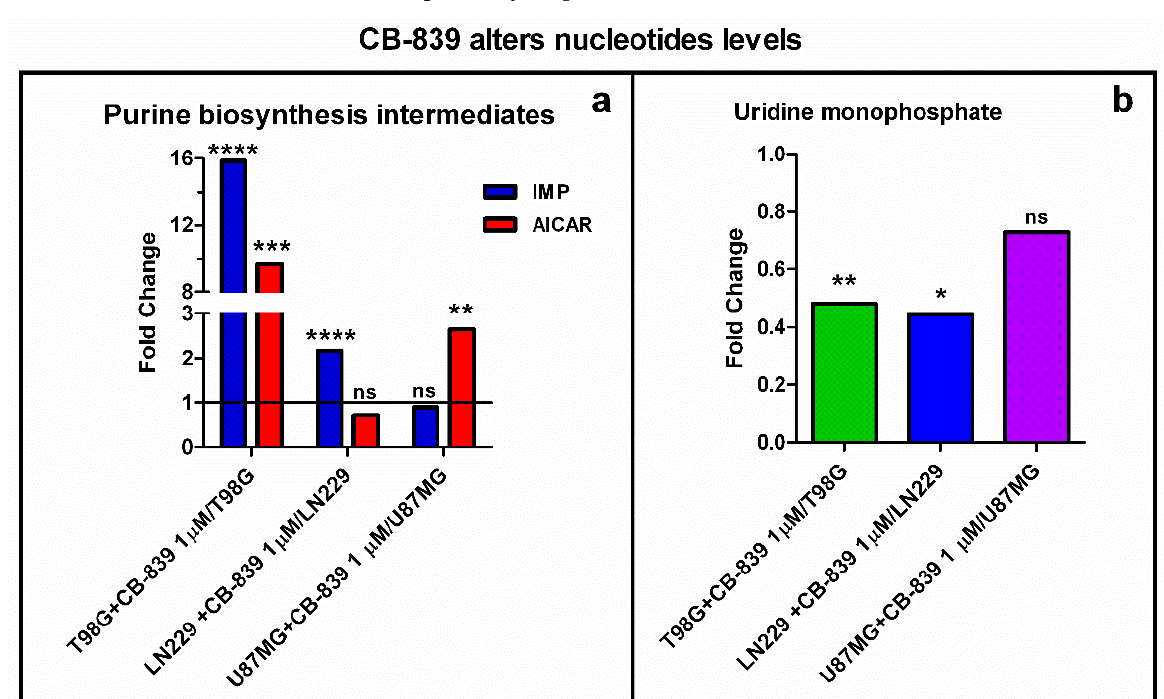
The metabolism of purine nucleotides was significantly modified in all GBM cell lines treated with CB-839. Inosine monophosphate (IMP) and the adenosine monophosphate analog AICAR were augmented in the three assayed GBM cell lines (relevant results are depicted in Figure 12a). Again, T98G showed the highest change in purine de novo biosynthesis intermediate levels, rising as much as 16-fold (IMP) and 10-fold (AICAR), while LN229 showed increased IMP (2.17-fold) and U87MG showed increased AICAR (2.65-fold). Uridine monophosphate (UMP) was diminished 0.48-fold and 0.44-fold in T98G and LN229, respectively (Figure 12b).